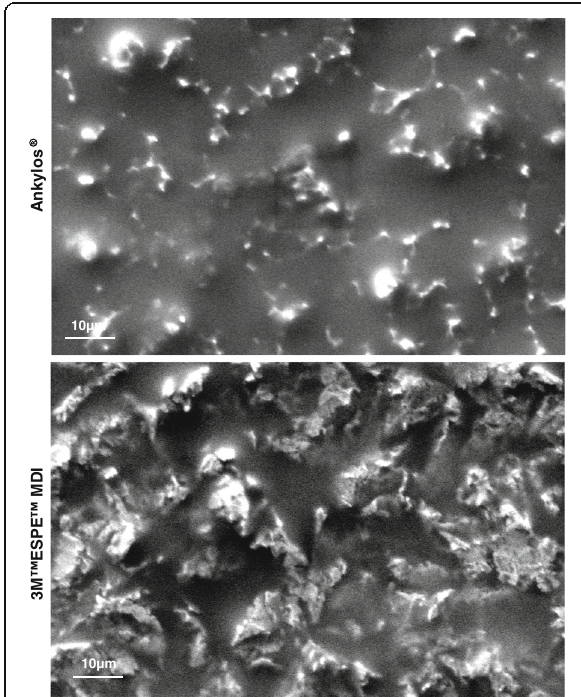
Fig. 2 Implant surface characterization under SEM. Increased surface roughness in the 3M ™ ESPE ™ MDI dental implants when compared to Ankylos® implants